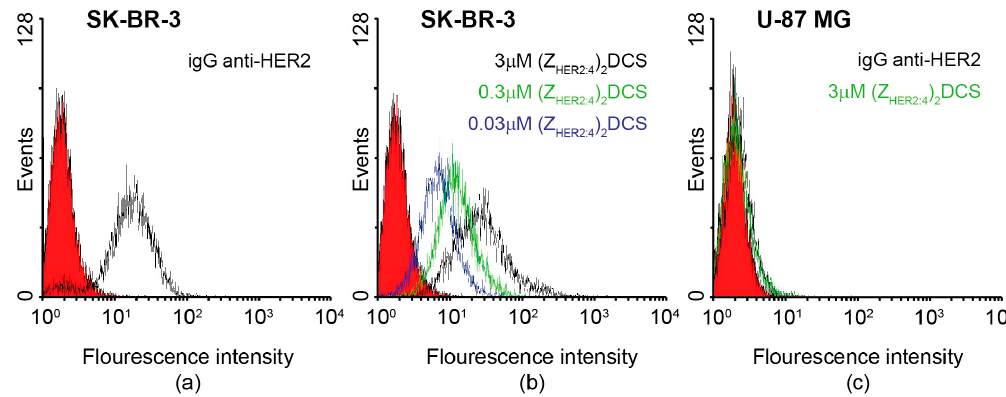
Figure 4. Specificity of the diaffibody-HER2 (Human Epidermal Growth Factor Receptor 2) binding analyzed by flow cytometry. ( a , b ) Positive staining was recorded for the HER2-positive SK-BR-3 cells with the anti-HER2 monoclonal antibody and with the fluorescently labeled diaffibody at three different concentrations: 0.03, 0.3 and 3 μ M. ( c ) Banding is observed for the control HER2-negative U-87 MG cells.